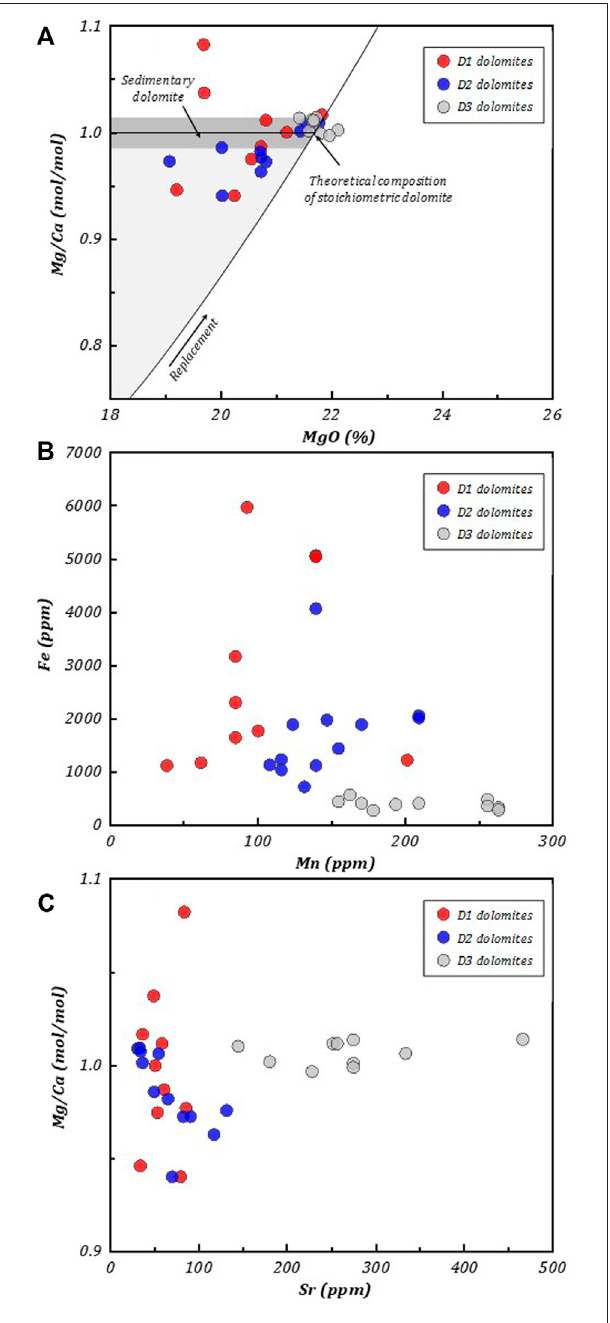
FIGURE 5 | Scatter diagrams of (A) MgO concentration with the Mg/Ca molarratio(after Warren, 2000;Zhanget al.,2014), (B) Mn concentrationwith Fe concentration, and (C) Sr concentration with the Mg/Ca molar ratio of the investigated Middle – Upper Cambrian Xixiangchi dolomites.